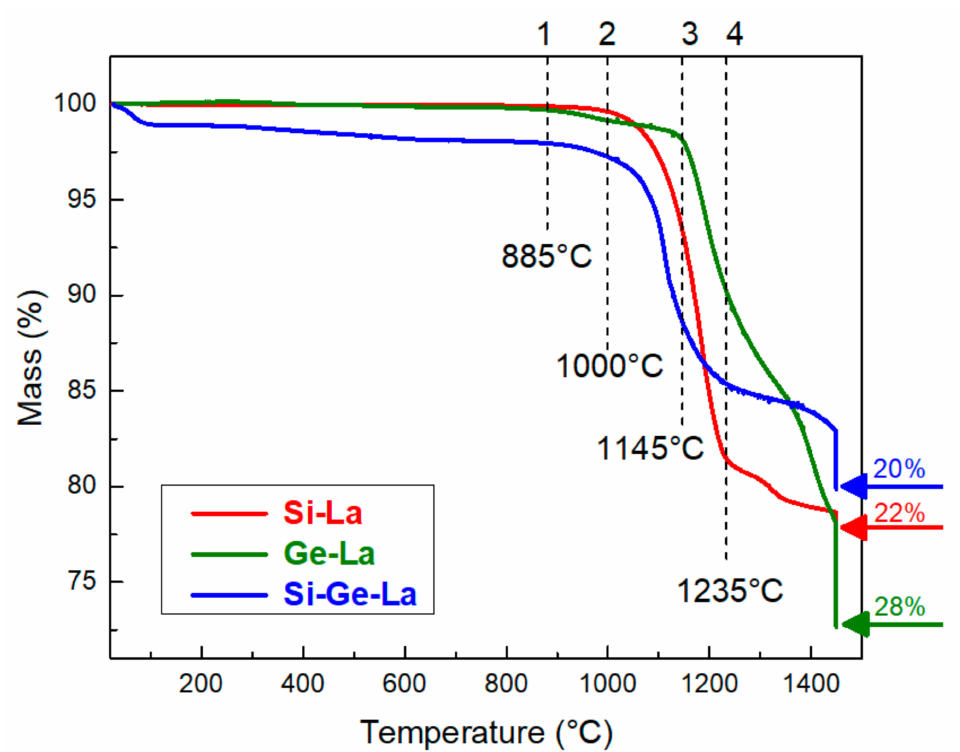
Figure 7. TGA curves of the three different